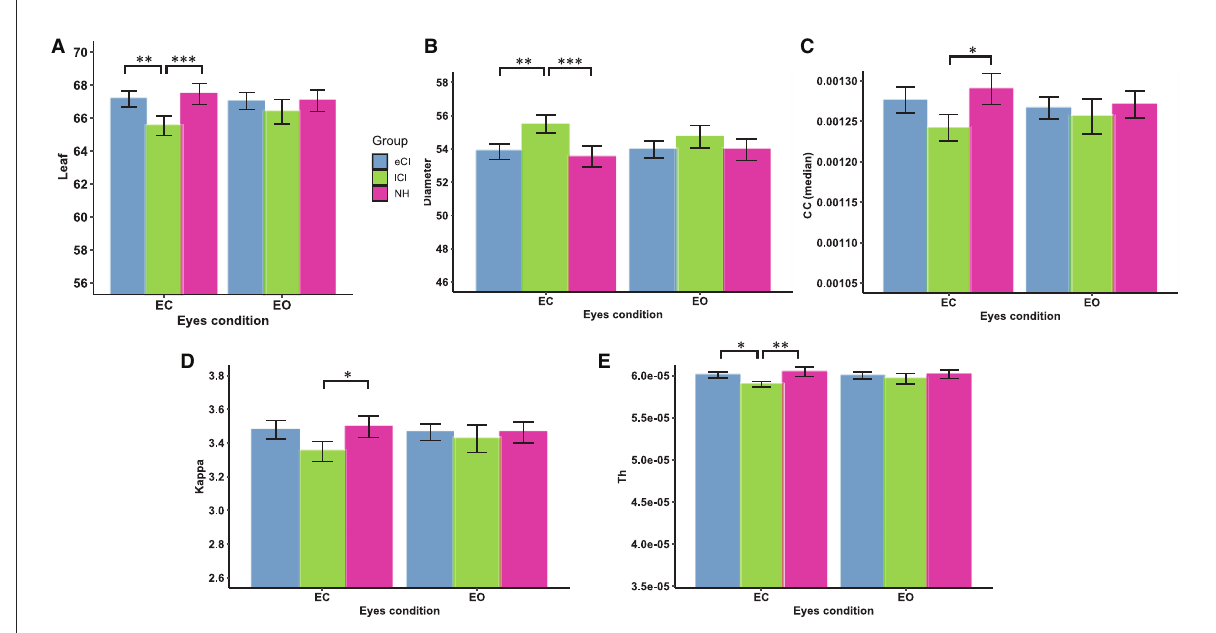
FIGURE7 Comparison of network characteristics between the eyes-closed (EC) and eyes-open (EO) conditions for children with early cochlear implantation (eCI), children with late cochlear implantation (lCI), and children with normal hearing (NH) in the theta band (4–8 Hz). MST characteristics in the theta band are shown for the eCI group (blue), lCI group (green), and NH group (red) for both the EC and EO conditions (x-axis). The main differences between groups were found for (A) leaf number, (B) diameter, (C) closeness centrality (CC; median), (D) kappa, (E) tree hierarchy (Th). Compared with the lCI group, the NH and eCI groups had higher (A) leaf, (D) kappa, and (E) Th values and lower (B) diameters under the EC condition. ∗ p < 0.05, ∗∗ p < 0.01, and ∗∗∗ p < 0.001.